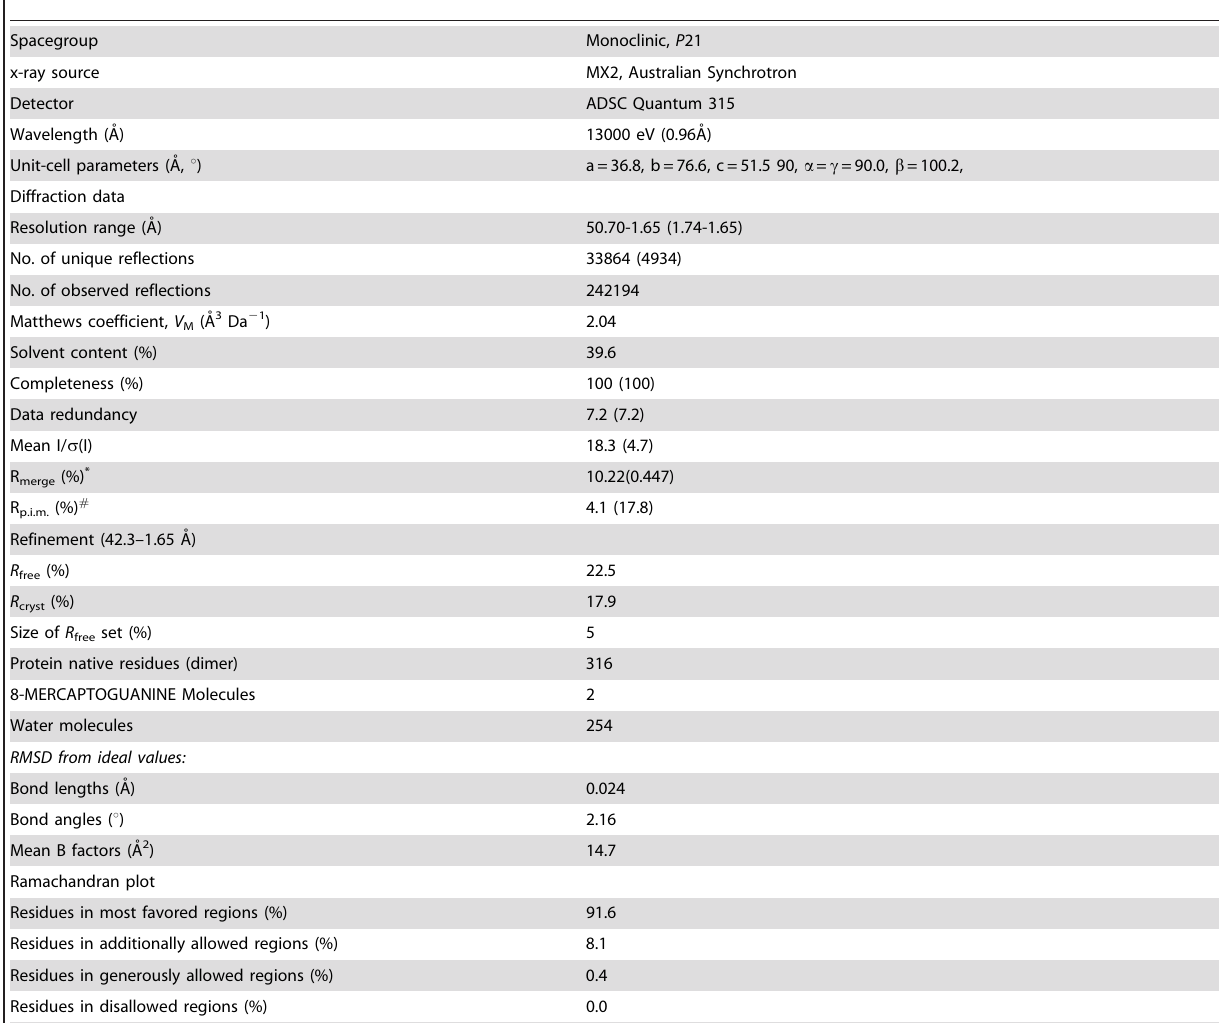
Table 2. X-ray structure data processing and refinement